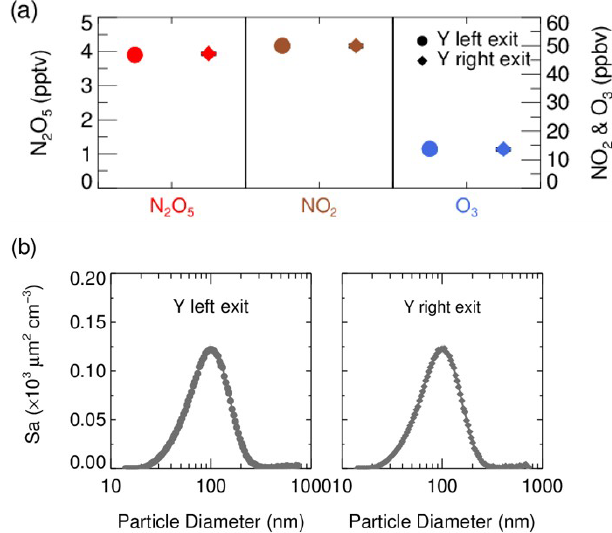
Figure 2. (a) The concentrations of N 2 O 5 , NO 2 and O 3 in the mix- ture of the N 2 O 5 source and sampling aerosols measured at each exit of the Y-tee; (b) the size distribution of S a concentration in the mixture of the N 2 O 5 gas source and sampling aerosols measured at each exit of the